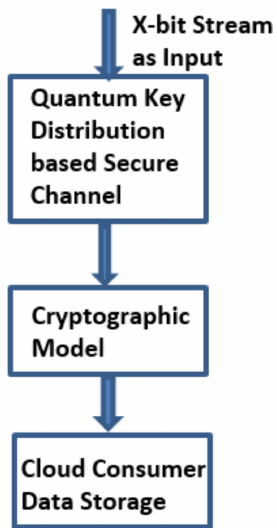
Figure 5. QKDs Cryptographic